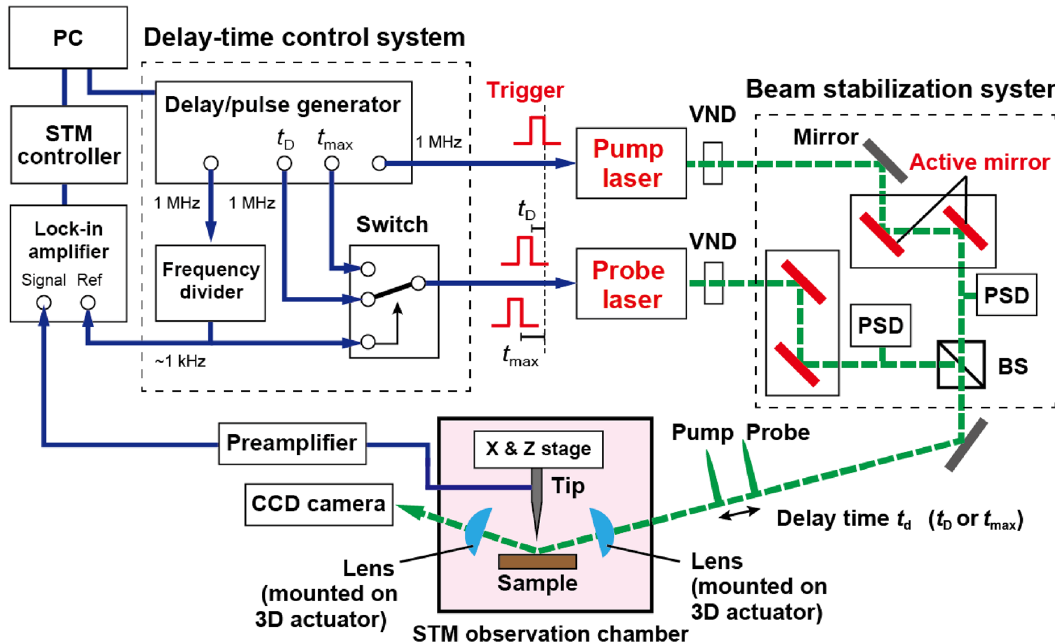
Figure 1. Schematic diagram of the OPP-STM system. PSD: position sensitive detector, BS: beam splitter, VND: variable neutral density